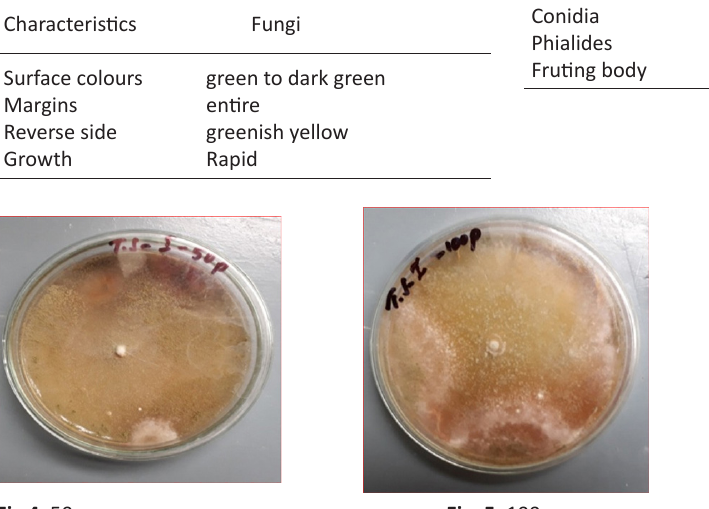
Fig 4 . 50 ppm Fig. 5 . 100 ppm Fig. 6 . 400 ppm (Fenitrothion degradation at different ppm